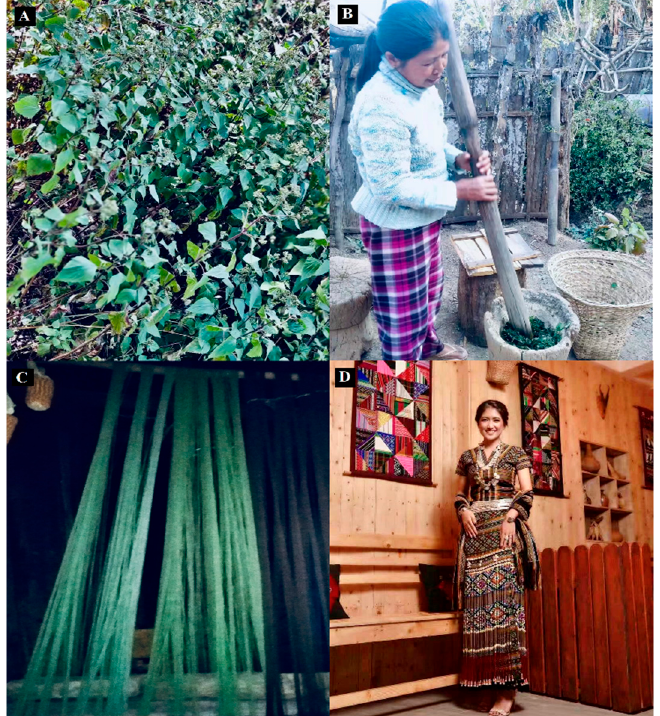
Figure 3. ( A ) Ageratina adenophora plants, ( B ) crushing the leaves of A . adenophora using a traditional mortar and pestle (also known as sung-cuo and sung-khe in Lutuv: Chin) before boiling with water by Ms. Cherry in Hnaring, ( C ) cotton thread dyed green with A . adenophora leaves, and ( D ) Ms. Deborah Van Dawt Sung wearing traditional dress.